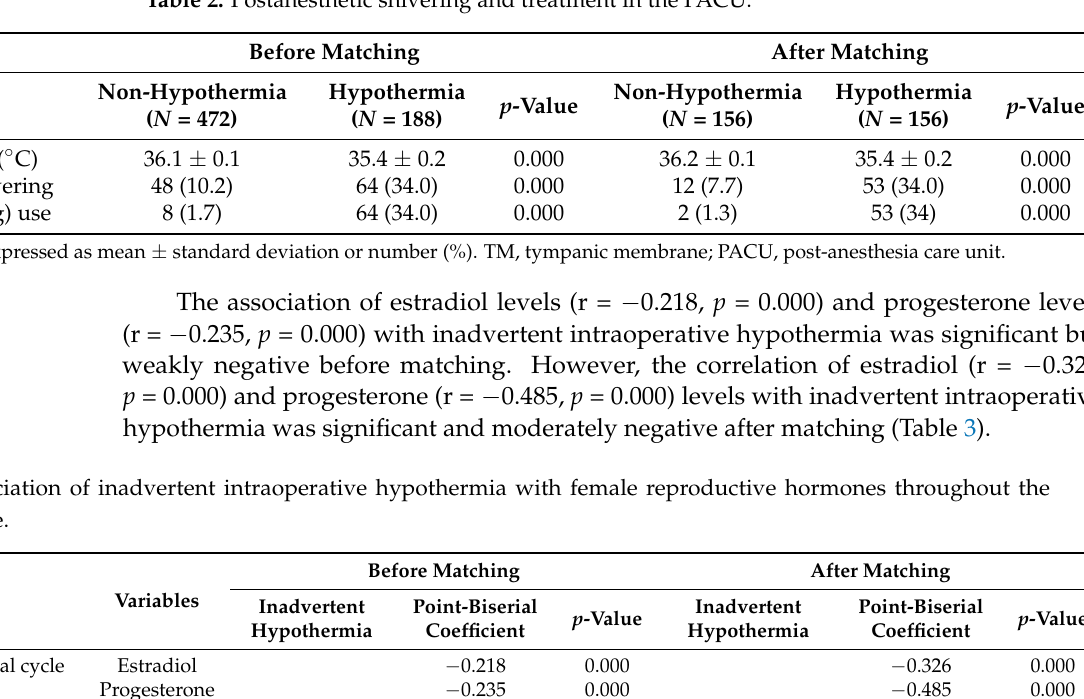
Table 2. Postanesthetic shivering and treatment in the PACU.